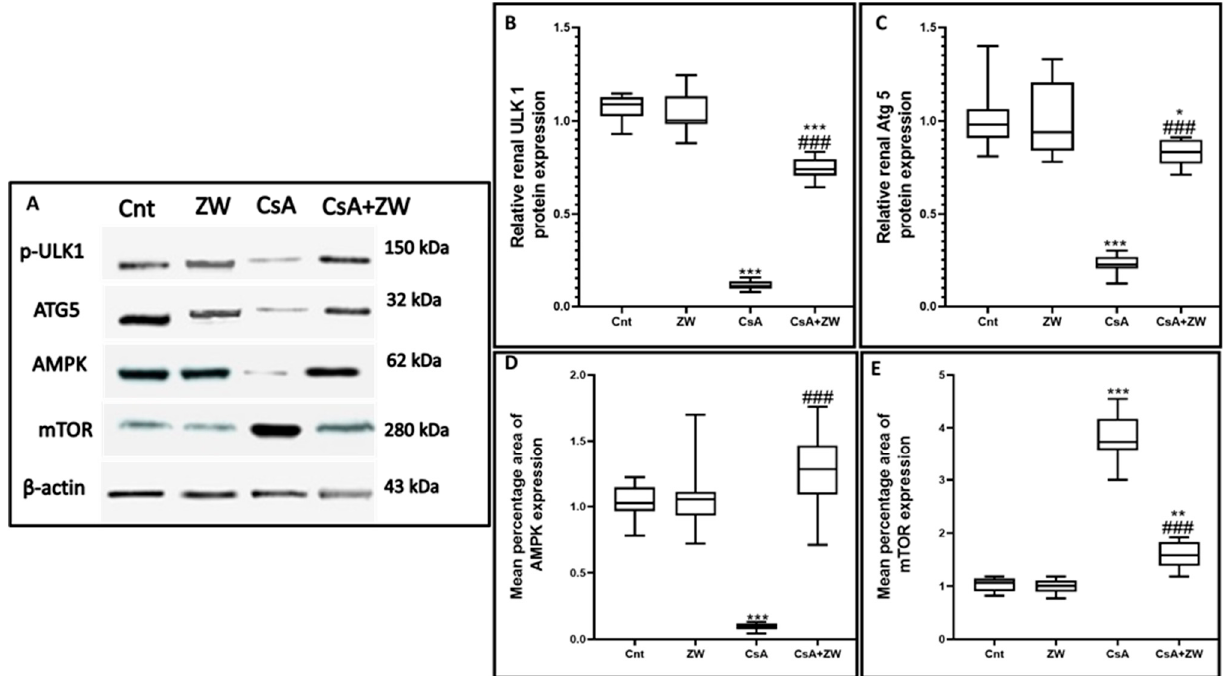
Figure 11. In fl uence of ZW on the protein expression of (A,B) P UlK-1, (A,C) Atg5, (A,D) AMPK, and (A,E) mTOR proteins according to Western blo tt ing assay. *** p < 0.001, ** p < 0.001, and * p < 0.05 vs. control ; ### p < 0.001vs. CsA.